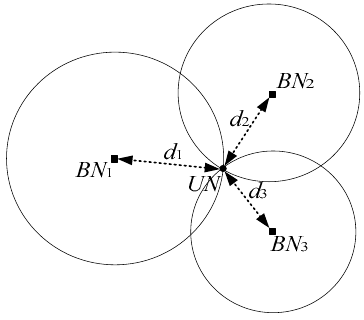
represent the estimated location of the unknown